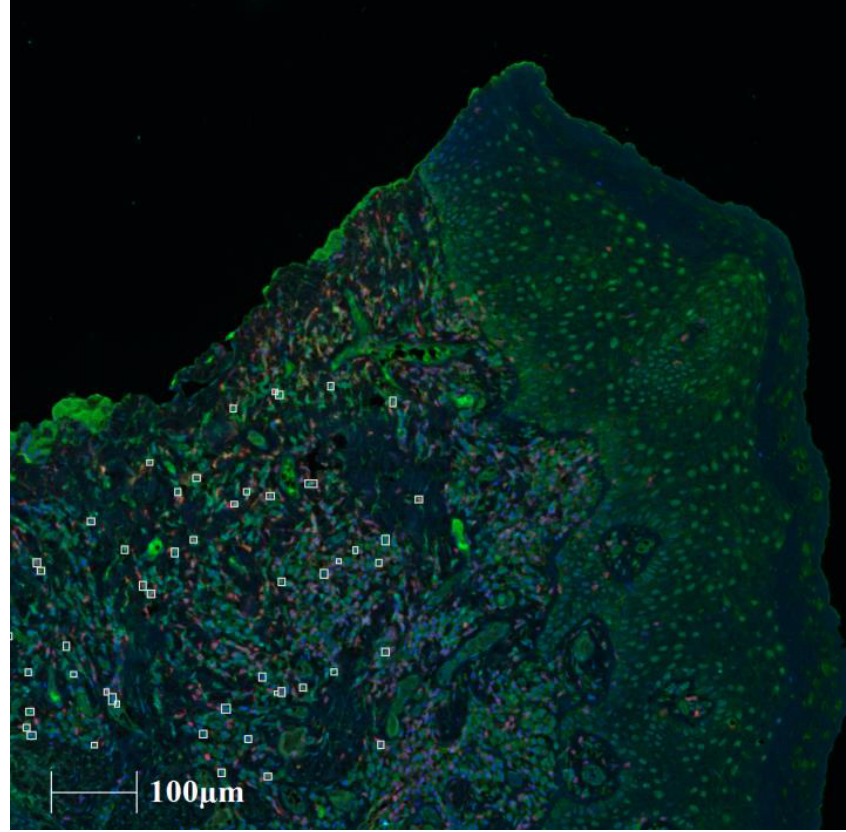
Figure 2. Representative image of MAIT cell phenotyping. OLP-asymptomatic sample after CD3 + CD161 + TCRVα7.2 + phenotype analysis. Legend: White boxes identify the CD3 + CD161 + TCRVα7.2 + - positive cells.